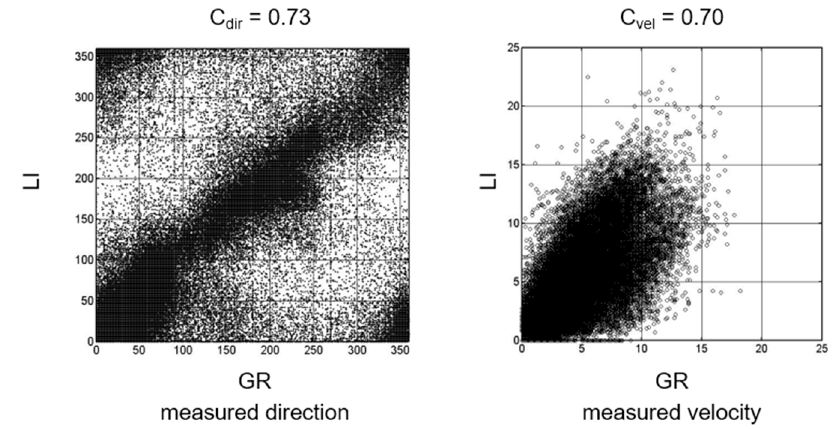
Figure 6. Cross correlation analysis between wind data measured by Lignano and Grado anemometers.